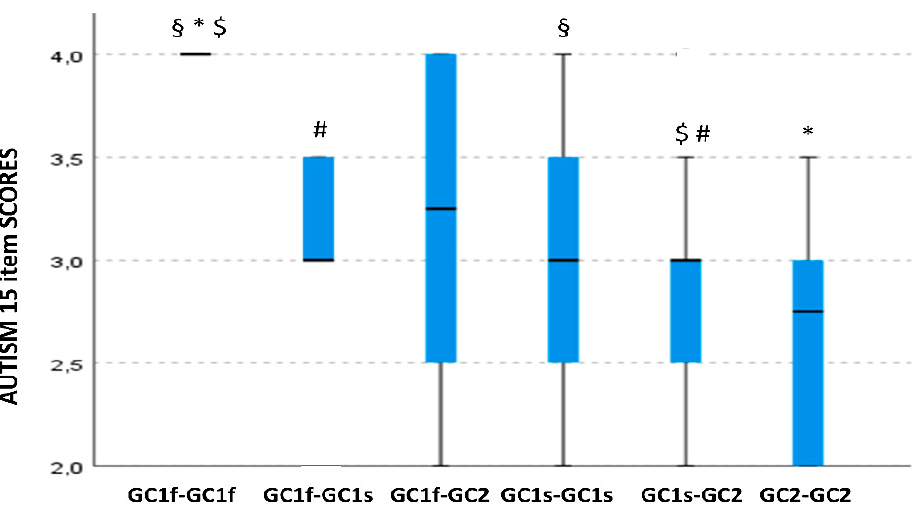
Figure 3. Boxplot of the distribution of autism 15 item scores in relationship with the GC isoform phenotypes. Within each box black lines denote median values. Statistically significant pairwise comparisons are reported: *: p = 0.008 §: p = 0.02 $: p = 0.01 and #: p = 0.049.